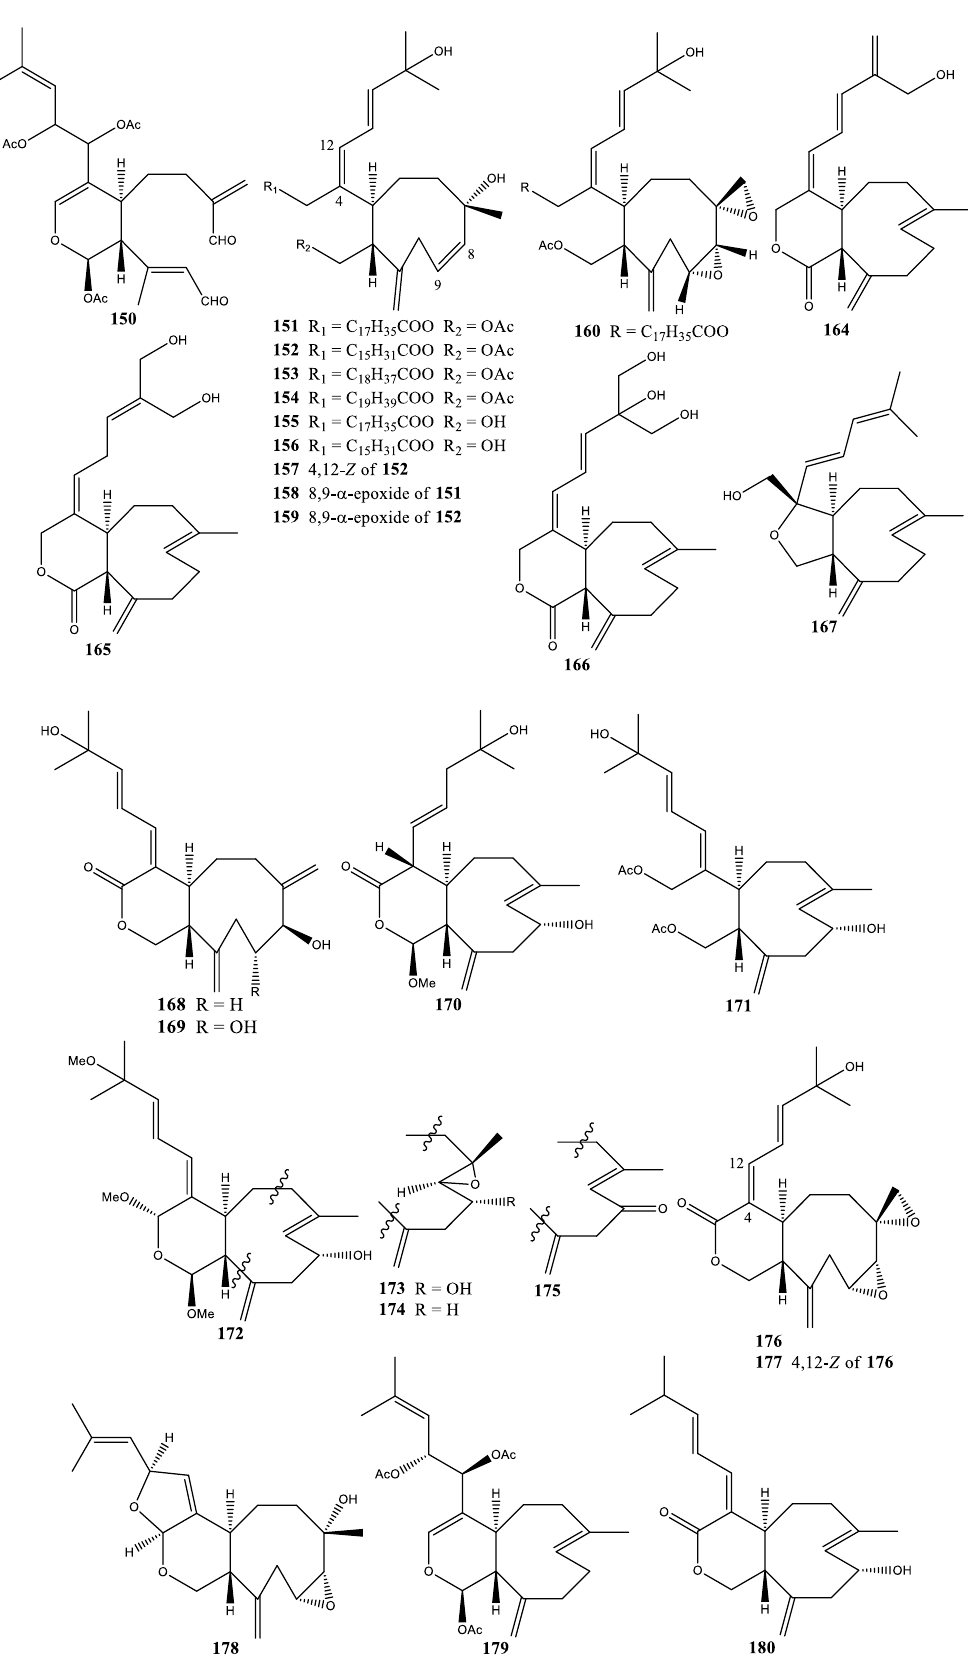
Figure 8. Structures of compounds 131–180 .